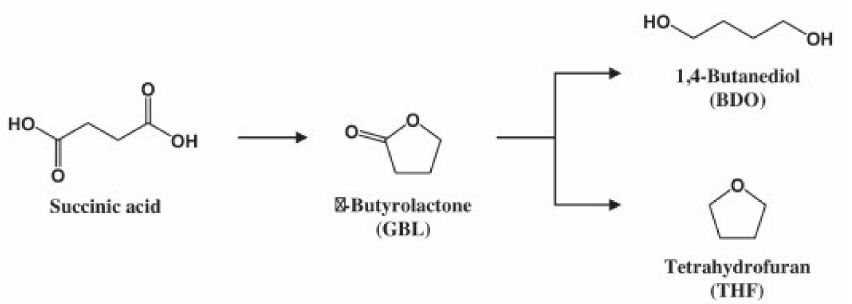
Figure 5. Reaction of succinic acid into 1,4-butanediol to produce PBS [46]. Adapted with permission from Delhomme